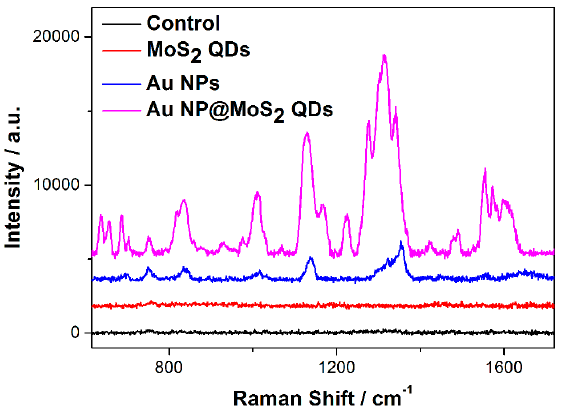
Figure 6. The mean SERS spectra of 4T1 cells triggered by MoS 2 QDs, Au NPs, and the nanohybrids after incubation of 12 h. Materials 2017 , 10 , 650